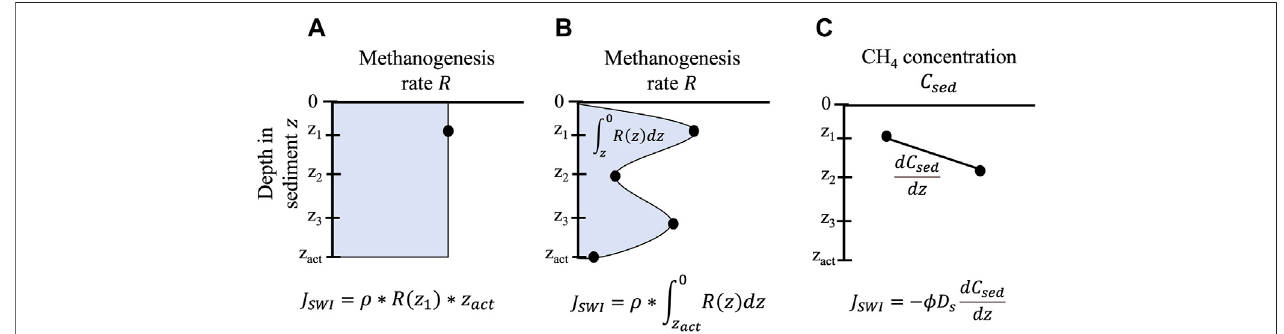
FIGURE 2 | Multiple approaches for measuring diffusive fl ux from sediments ( J SWI ) using point measurements of methanogenesis ( R ) or CH 4 concentrations ( C sed ) in the sediment column. Points indicate discrete measurements taken at depths z , with z act denoting the sediment depth below which methanogenesis is considered negligible. The SWI is where z = 0. Note that all axes are not drawn to scale. Below each panel, the equation for fl ux is shown, with ρ indicating sediment bulk density, ϕ sediment porosity ( Eq. 1 ), and D s sediment diffusivity ( Eq. 1 ). (A) Converting one measurement of CH 4 production into fl ux by assuming methanogenesis is